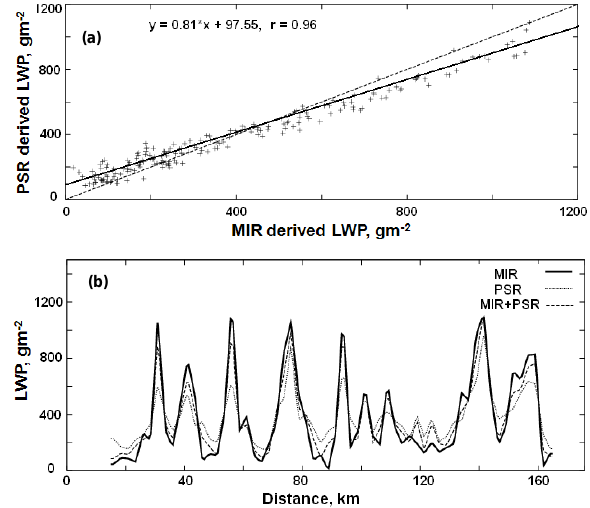
Figure 10: Comparison of the liquid water paths based on the MIR and PSR data: (a) scatter plot with the robust regression line (solid) and the line of equal LWPs (dash); (b) LWPs as a function of distance.